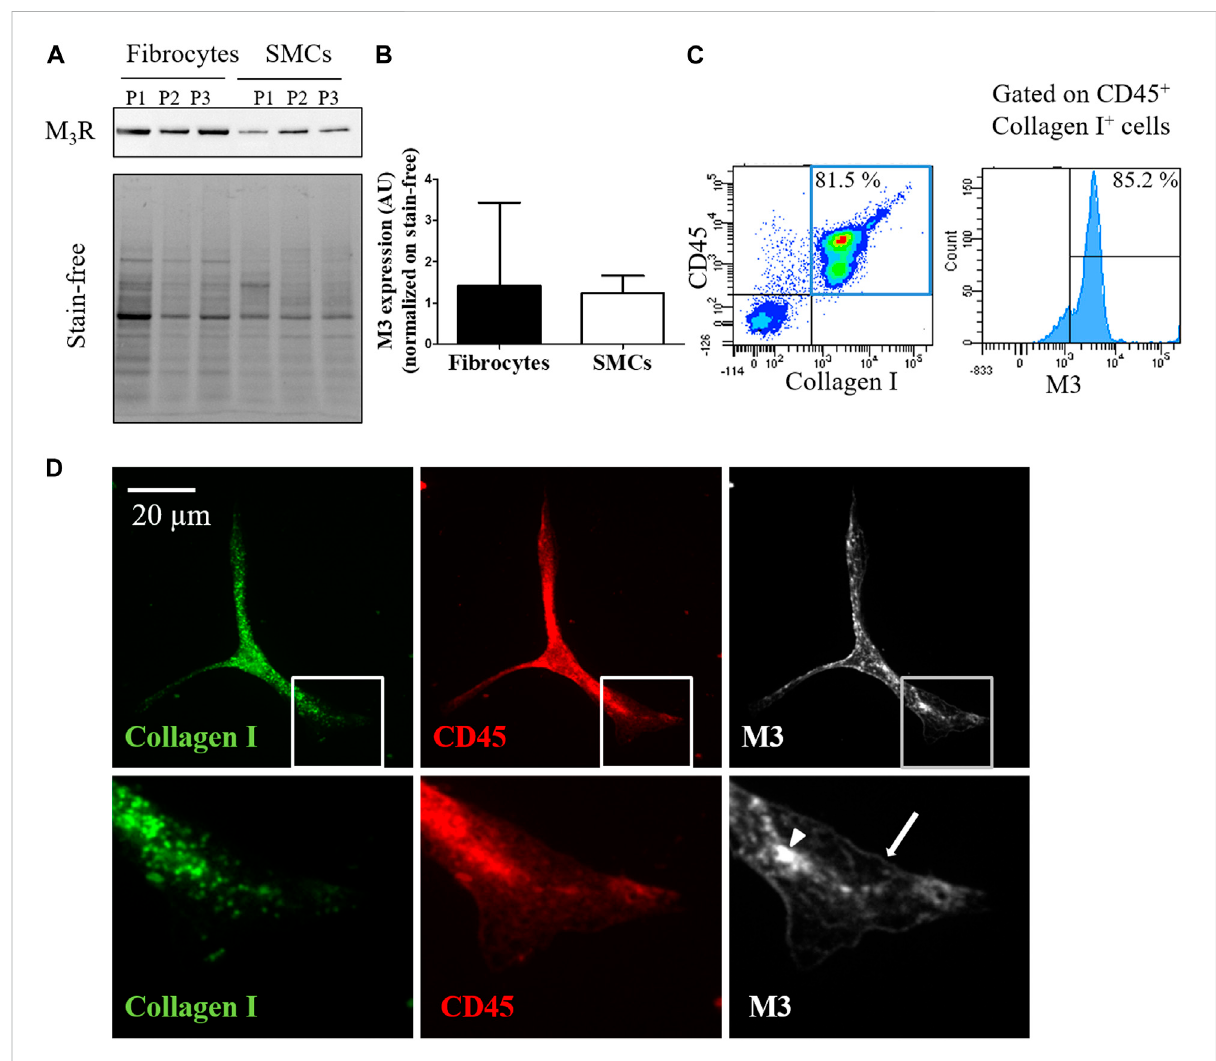
FIGURE 1 Fibrocytes from patients with COPD express the muscarinic M3 receptor. (A) . Presence of M3 receptor (M 3 R) is assessed in cultured fi brocytes from patients with COPD or in bronchial smooth muscle cells (SMCs) by Western blot. Total protein load is shown with the stain-free image. (B) . quanti fi cation of M 3 R expression normalized on stain-free. No signi fi cant difference is found between fi brocytes and SMCs ( p = 0.40). (C) . M3 receptor is identi fi ed by fl ow cytometry in fi brocytes isolated from the blood of COPD patients. In the represented experiment, 85.2% of fi brocytes (double-positive CD45-Collagen I cells, blue square) express M3. (D) . Representative confocal photographs show the expression of M3 receptor (white) evidenced in the cytoplasm (arrow head) and at the surface (arrow) of a fi brocyte (CD45 + Collagen I + fusiform